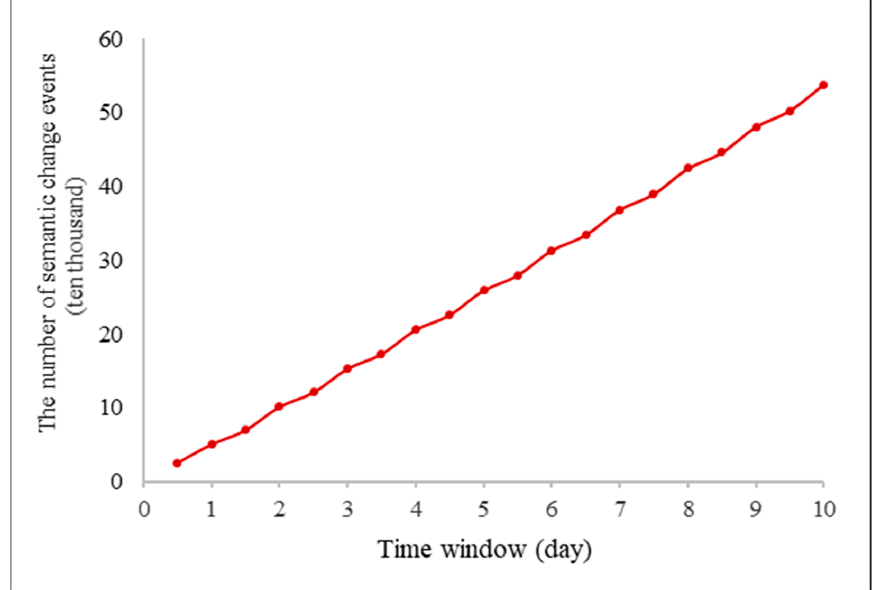
Figure 5. The average number of semantic change events for different time windows.